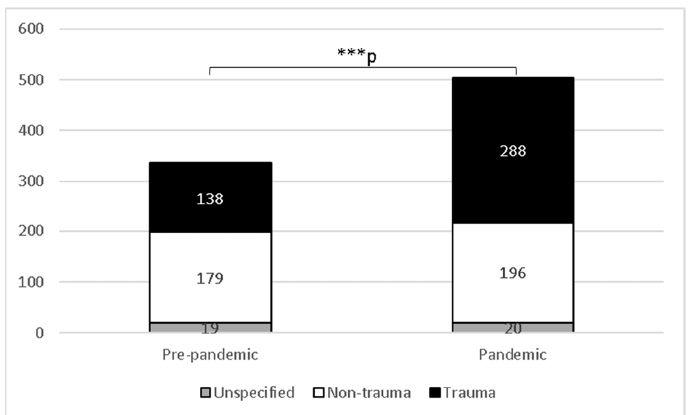
Figure 2. Number of telemedicine consults in pre-pandemic and pandemic periods at University Hospital Center Osijek, Croatia. *** p < 0.0001, χ 2 test with Yates’s correction.